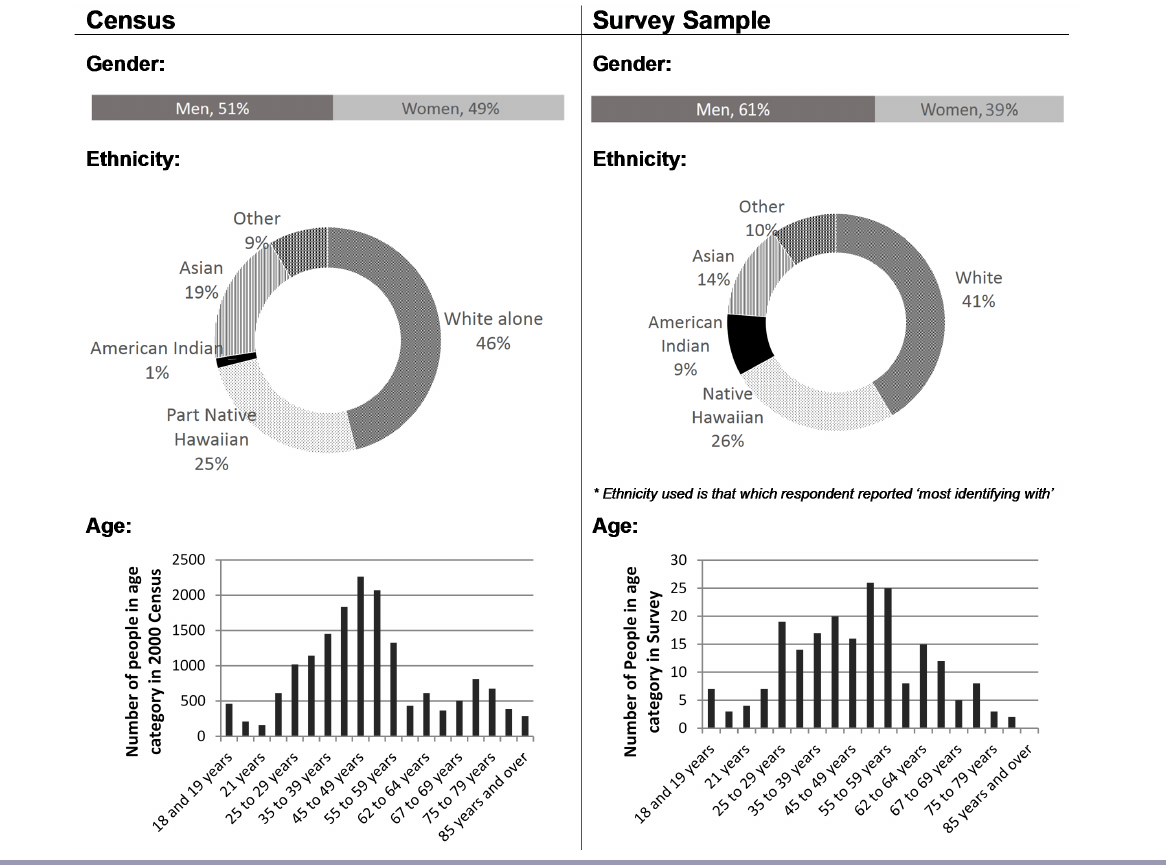
Fig. 1 . Comparison of demographic information for the census vs. the survey